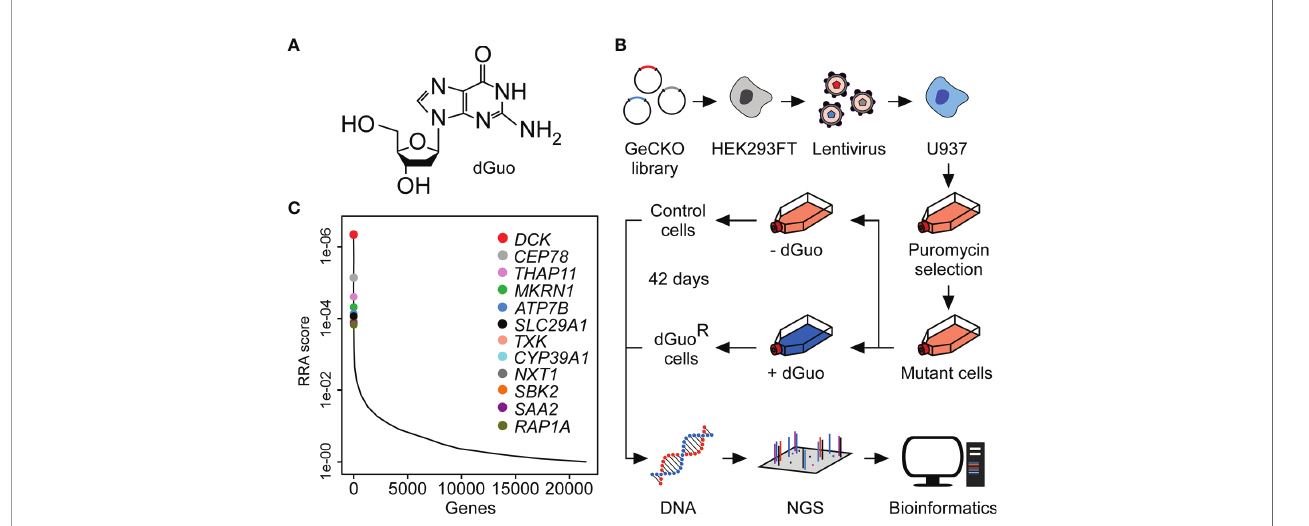
FIGURE 3 | Genome-wide CRISPR-Cas9 screen uncovers host factors conferring susceptibility to cytotoxic deoxyguanosine. (A) Chemical structure of deoxyguanosine (dGuo). (B) Schematic diagram illustrating the CRISPR-Cas9 screening approach used to identify host determinants that mediate susceptibility of the U937 macrophage cell line to dGuo. (C) Discovery of the top candidate genes following dGuo treatment of U937 cells by next generation sequencing (NGS). Data were analyzed using the MaGeCK-based robust rank aggregation (RRA) score analysis and are representative of two independent replicates (see also Supplementary Figure 3 ). A smaller RRA score indicates more essentiality. The twelve top-ranked genes are